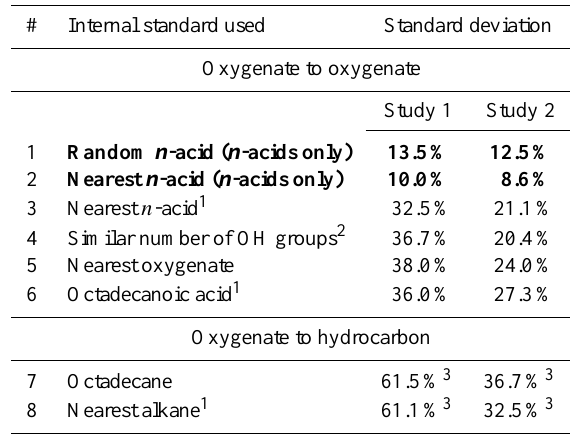
Table 1. Standard deviation in error for correction of run-to-run variability of oxygenates using a variety of possible scenarios for pairing analytes to internal standards. Full distribution of error for scenarios in bold are shown in Fig. 4. In all cases, “nearest” refers to closest in volatility.